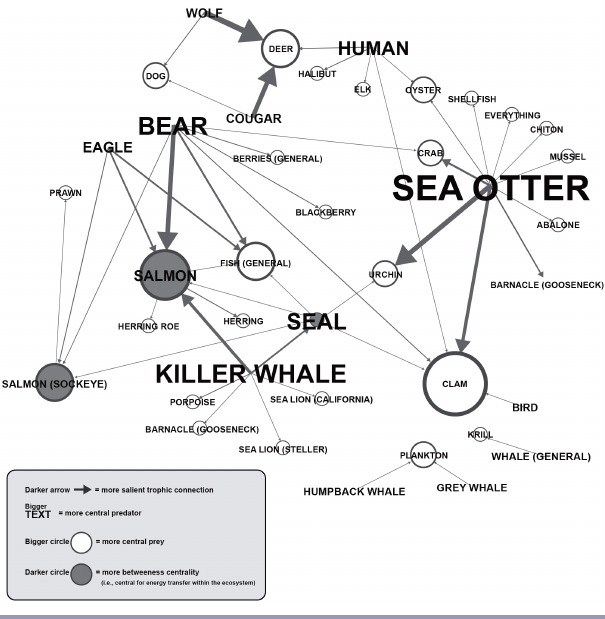
Fig. 5 . Aggregate mental model of the regional foodweb: First Nations. First Nations’ aggregate model is cognitively dominated in terms of salience by the feeding habits of charismatic terrestrial predators (wolves, bears, cougars) as well as that of sea otters and, to a lesser extent, killer whales. Sea otters, in particular, emerge as especially central predators in First Nations’ model, given the vast array of individual prey species otters are collectively believed to eat. Bears and killer whales are also regarded as relatively prolific predators, but it is their penchant for salmon that emerges as an especially important feature of First Nations’ model. Salmon, in turn, are regarded by First Nations both as a central prey species, but also as marine predators in and of themselves. As such, for First Nations, salmon constitute the most central species in the food web with regard to facilitating energy transfer throughout the ecosystem. Seals occupy a similar, but slightly less central, role in First Nations’ collective model. Humans are acknowledged as somewhat prolific predators, but with a low degree of salience. Baleen whales are noted for their predation on plankton and krill, but these relationships remain conceptually detached from the wider food web. Among First Nations, it appears that after salmon it is clams, specifically, that are regarded as the most widely targeted prey species in the ecosystem. (Note that this visualization is demonstrative of the method’s potential uses, not necessarily representative of a demographic with statistically distinct